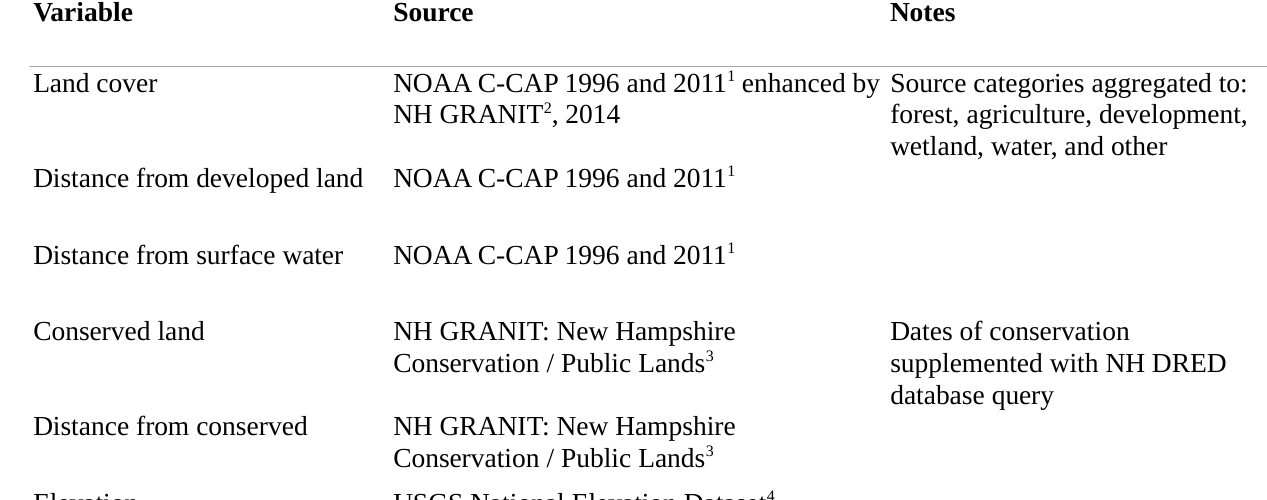
Table A2.1. Variables included in regression tree